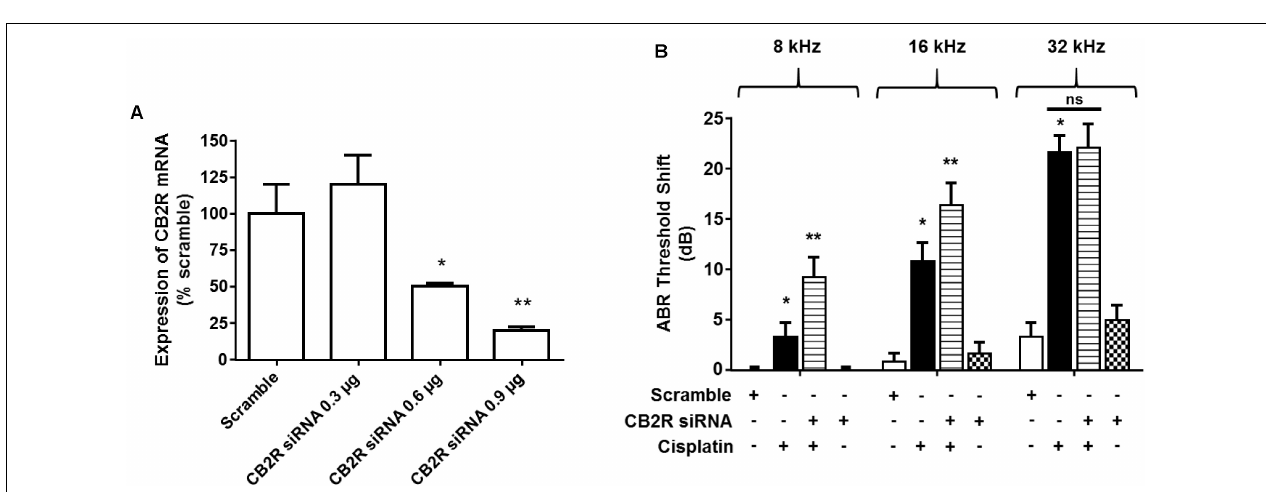
FIGURE 7 | Knock-down of CB2R expression by siRNA increases the sensitivity to cisplatin-induced hearing loss. (A) Rats were administered either scramble siRNA (0.9 µ g) or increasing doses of CB2R siRNA (0.3, 0.6, and 0.9 µ g) by trans -tympanic injections. The animals were sacrificed 48 h later and mRNA was assessed for CB2R expression by real-time RT-PCR. CB2R siRNA knocked down CB2R gene expression by ∼ 50 and ∼ 80% using 0.6 µ g and 0.9 µ g, respectively. Data are represented as % expression ± SEM ( n = 3). ∗ p < 0.05 vs. scramble siRNA and ∗∗ p < 0.05 vs. CB2R siRNA 0.6 µ g. (B) Baseline ABR was recorded in rats administered with either a scramble siRNA or CB2R siRNA by trans -tympanic injections for 48 h. Cisplatin (11 mg/kg, i.p.) was then administered and post-ABR was recorded 72 h later. There was no significant change in ABR threshold shift in the animals treated with scramble siRNA or CB2R siRNA alone. Pre-treatment